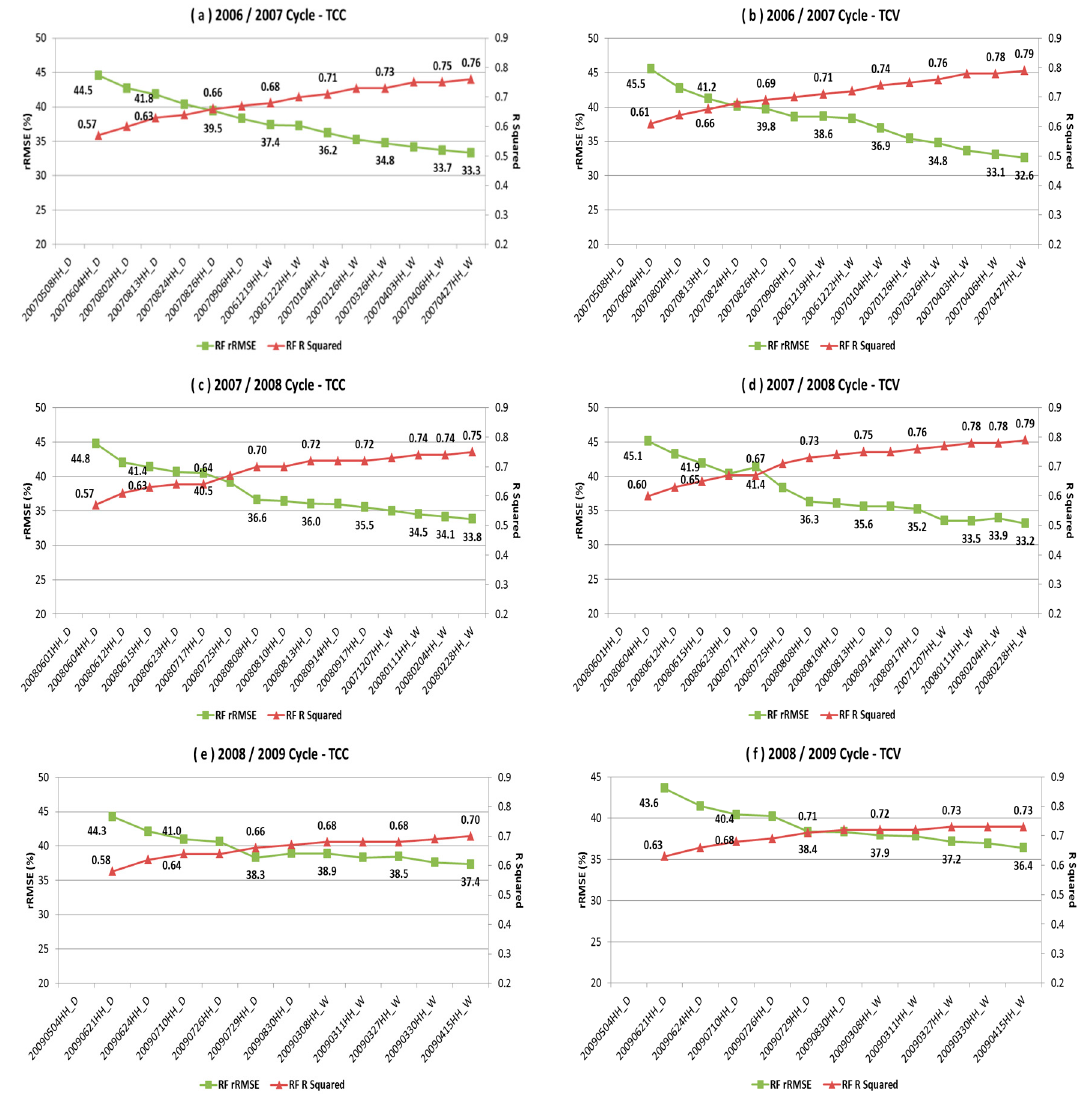
Figure 4. ( a – f ): Results from the sequential addition of the individual dry and wet images, per phenological cycle, to the modelling process, for both TCC and TCV metrics. The first two images of each scenario are used as the starting combination.